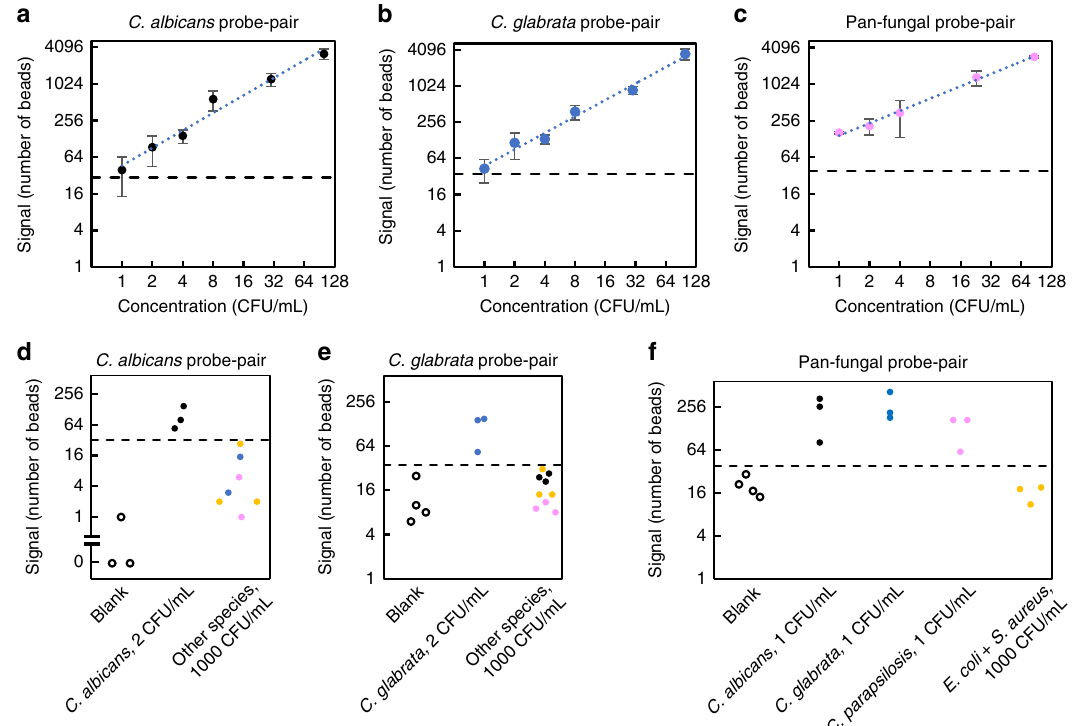
Fig. 2 SMOLT detection of Candida in human whole blood. Human whole blood samples were spiked with Candida cells at indicated concentrations. a – c Detection of Candida across the range of clinical concentrations. Data plotted on Log 2 scale for both axes. The signal increased with increasing concentrations. The dotted blue line in each panel is a linear function fi tted to the data. Data are represented as mean ± SD, n = 3 independent experiments. a C. albicans probe pair detecting C. albicans ( R 2 = 0.9731). b C. glabrata probe pair detecting C. glabrata ( R 2 = 0.9831). c Pan-fungal probe pair detecting C. parapsilosis ( R 2 = 0.9958). The cutoffs (black dashed line) were de fi ned above the mean plus two times the SD of the blank samples signal for each probe pair. LOD and cross-reactivity of the d C. albicans probe pair; e C. glabrata probe pair; and f pan-fungal probe pair. Blank samples (empty circles), C. albicans (black circles), C. glabrata (blue circles), C. parapsilosis (pink circles) and E. coli plus S. aureus (yellow circles). The LOD was de fi ned as the concentration for which three measurements were above cutoff with no measurement below cutoff. At each LOD concentration, the signal was signi fi cantly different from the blank signal, each with p < 0.05. Unpaired two-tailed Student ’ s t test wa s used for comparing two concentrations and p values are d p = 0.028, e p = 0.011, f p = 0.022 for C. albicans, p = 0.0097 for C. glabrata, p = 0.014 for C. parapsilosis using pan-fungal probe pair. Samples spiked with E. coli plus S. aureus had 1000 CFU mL − 1 of each species. Source data are provided as a Source Data fi